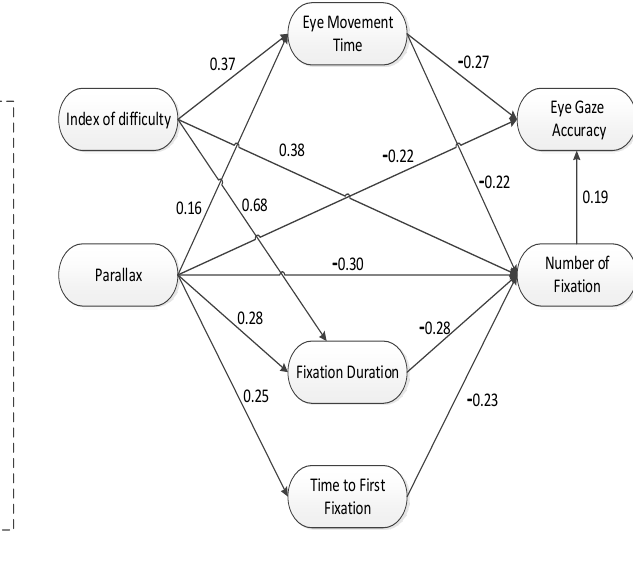
Fig.6. Final SEM model for eye movement parameters in projection-based stereoscopic